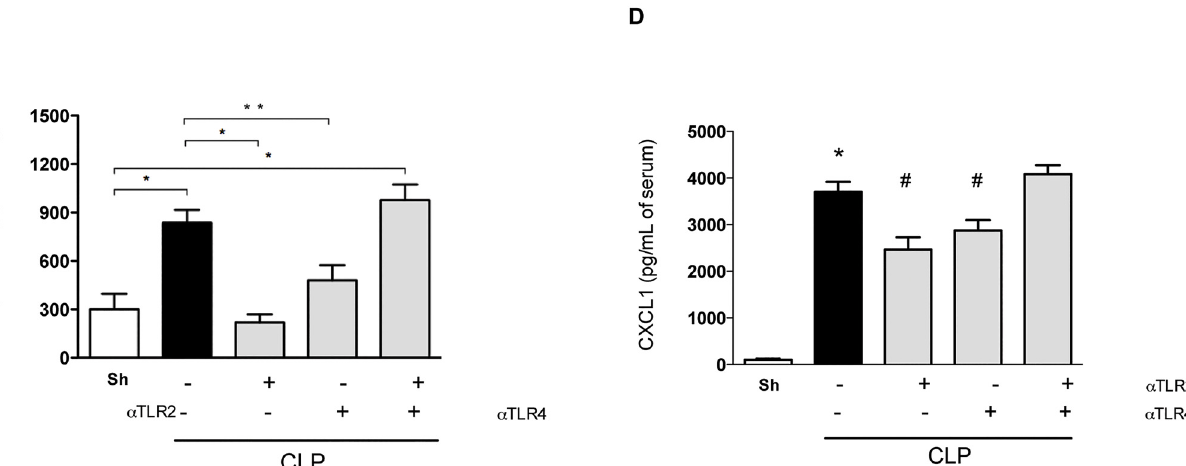
Fig 4. Blockade of either TLR2 or TLR4 reduces lung inflammation after polymicrobial sepsis. Mice were pre-treated with individual or combined anti- TLR2 or anti-TLR4 antibodies (45 minutes before the CLP procedure). Single treatment resulted in lower levels of TNF- α (A), IL-1 β (B), CXCL1 (C) and myeloperoxidase in the lung 6 hours after sepsis compared to the negative control isotype IgG antibody treatment (black bar). The combined treatment with both anti-TLR2 and anti-TLR4 showed moderate improvement when compared to the control treatment-group. * p < 0.05 between the CLP and Sham groups. # p < 0.05 between the antibody treatment groups and negative control isotype IgG treated-group. Antibody dose (1 mg/animal). Used 6 animals/group, except isotype IgG antibody treated group (n = 10).